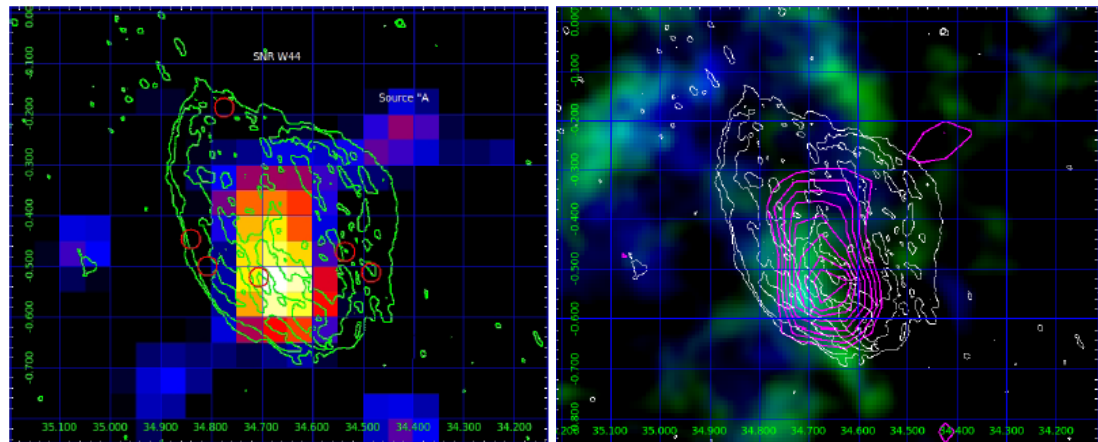
Figure 1. The SNR W44. Left: AGILE γ -ray intensity map between 400 MeV–1 GeV of the W44 region. Green contours and red circle indicate the 324 MHz radio detection from [79] and the OH masers from [80], respectively. Right: CO data from the NANTEN2 observatory. Magenta and white contours indicate the AGILE gamma-ray emission above 400 MeV and the VLA emission, respectively. Figure from [28].